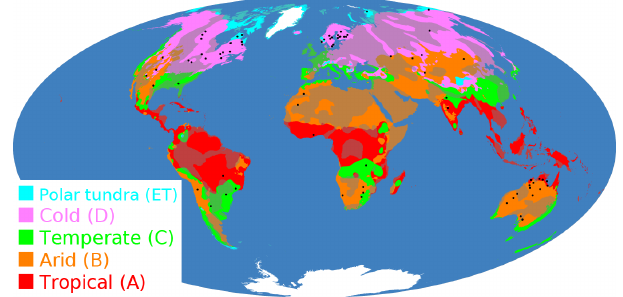
Figure 2. The primary Köppen–Geiger climate classes (Peel et al., 2007) considered in this study. Solid colors correspond to the pre- dominantly erosive provinces (shield, orogen, igneous), while the respective pale colors mark those regions not considered in order to avoid a bias by sediment deposition. The black dots show the 77 craters with diameters D ≥ 0 . 25km located in the predominantly erosive provinces being the basis of our